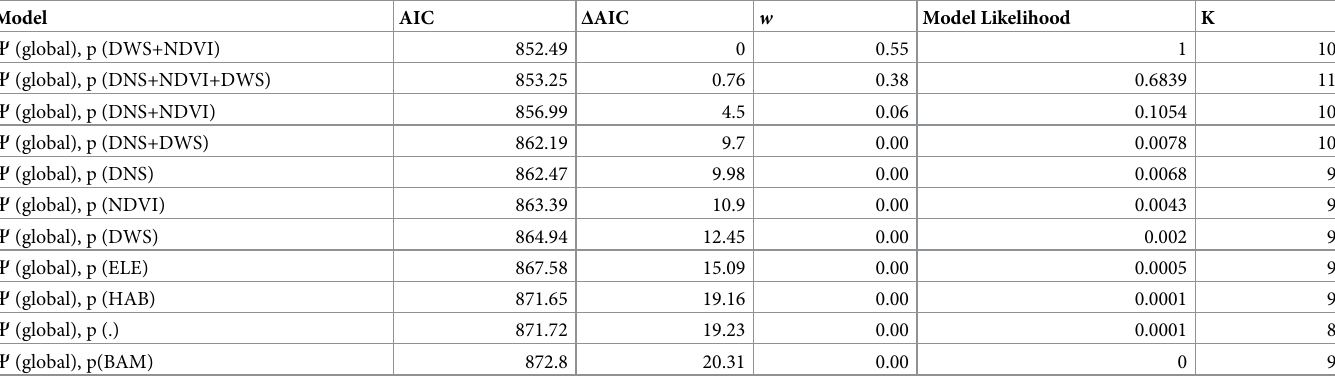
C = probability of site occupancy at the grid cell level; p = probability of detection; AIC is Akaike’s information criterion, Δ AIC is the difference in AIC value of the focal model and the best AIC model in the set, K is the number of model parameters and –2Loglik is -2 of the logarithms of the likelihood function evaluated at the maximum. Covariates considered: DNS: Distance to nearest settlement; DWS: distance to nearest water sources; NDVI: Normalized differential vegetation index; ELE: Average elevation, HAB: Available habitat, BAM: Bamboo cover in each grid cell, # In all models the probability of occupancy (Psi) was modelled as “ C ” (global: ELE